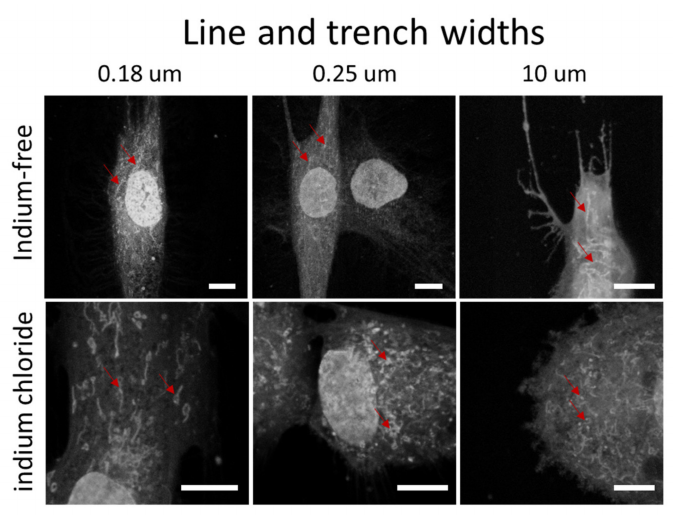
Figure 5. Fluorescence confocal micrographs of adherent cells stained with Mitotracker TM on parallel line/trench structures with widths of 0.18 µ m, 0.25 µ m and 10 µ m. Cells were cultivated in two different medium compositions—without and with indium chloride. Scale bars correspond to 10 µ m. The red arrows highlight some of the